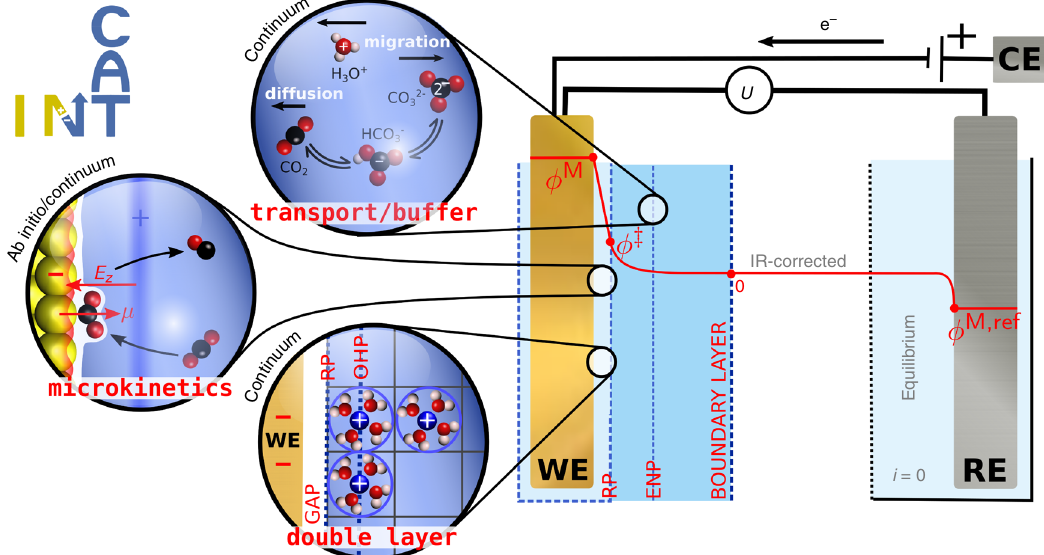
Fig. 3 Schematic illustration of the multiscale approach to electrocatalytic CO 2 reduction. Reaction kinetics obtained from fi eld-dependent DFT calculations are used to parameterize a microkinetic model. The model is coupled to a continuum mass transport model, which models the diffusion, migration, and reaction of species inside the boundary layer. This explicitly includes the double layer in which the electric fi eld drives the reduction of CO The double-layer model also includes the presence of a gap capacitance and cation repulsions at the outer Helmholtz plane (OHP), which are critical at the typically applied negative potentials. The thus-de fi ned multiscale approach predicts the CO production rate as a function of the applied electrode potential U ¼ ϕ M (cid:3) ϕ M ; ref þ Δ μ M , where Δ μ M is the chemical potential difference between the electrodes and U has been corrected for the IR potential drop. The reference electrode is in electrochemical equilibrium, so that all fl uxes i vanish. WE working electrode, RE reference electrode, CE counter electrode, RP reaction plane, ENP electroneutrality plane.